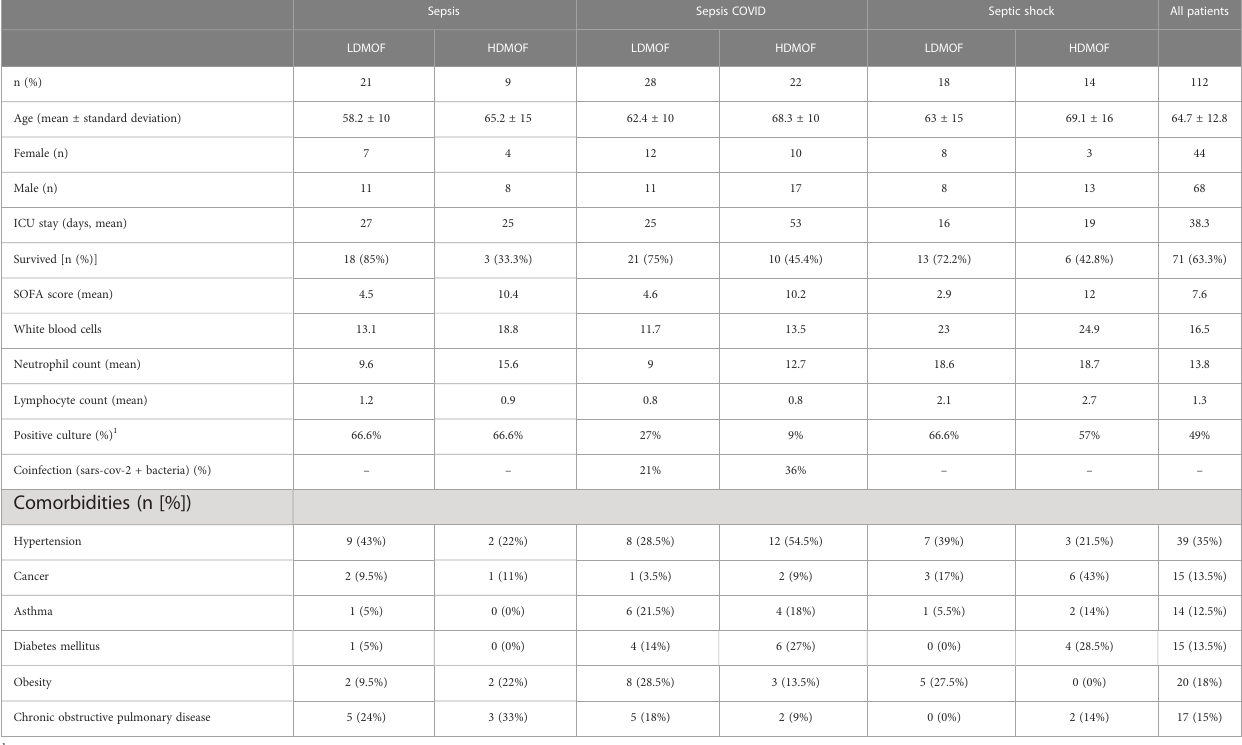
TABLE 1 Clinical characteristics of the